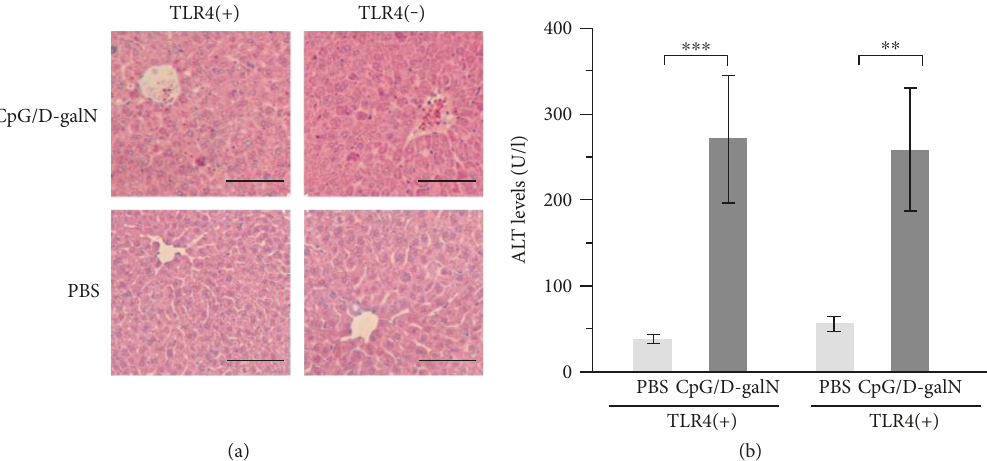
Figure 1: E ff ect of CpG/D-galN in TLR4(+) and ( − ) mice. (a) Histological analysis of the liver with hematoxylin-eosin staining. Scale bars indicate 100 μ m. (b) Serum ALT levels. ∗∗ p < 0 05 ; ∗∗∗ p < 0 03